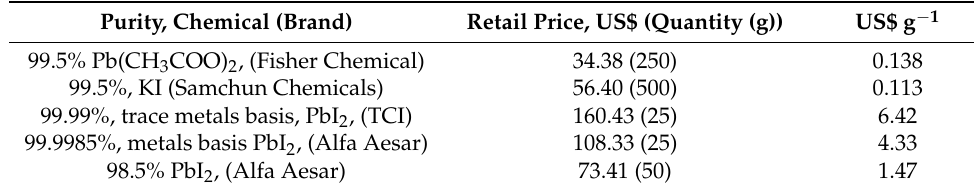
Table 1. Comparison of the retail prices of PbI 2 and chemicals for PbI 2 synthesis, providing purity 1 . Purity, Chemical